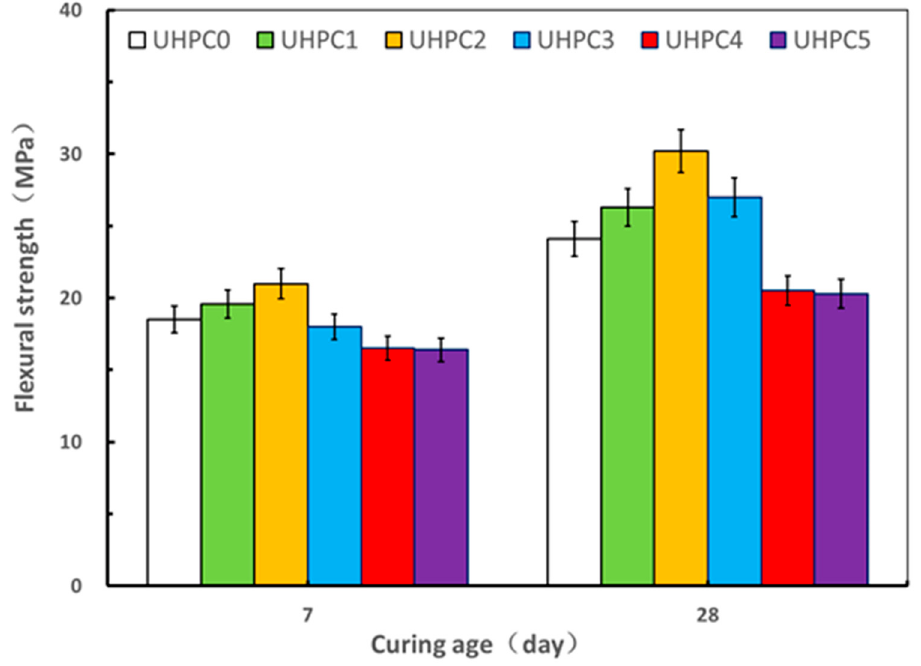
Figure 6. E ff ect of GO nanosheets on flexural under standard Figure 6. Effect of GO nanosheets on flexural under standard curing. Figure 6. Effect of GO nanosheets on flexural under standard curing.